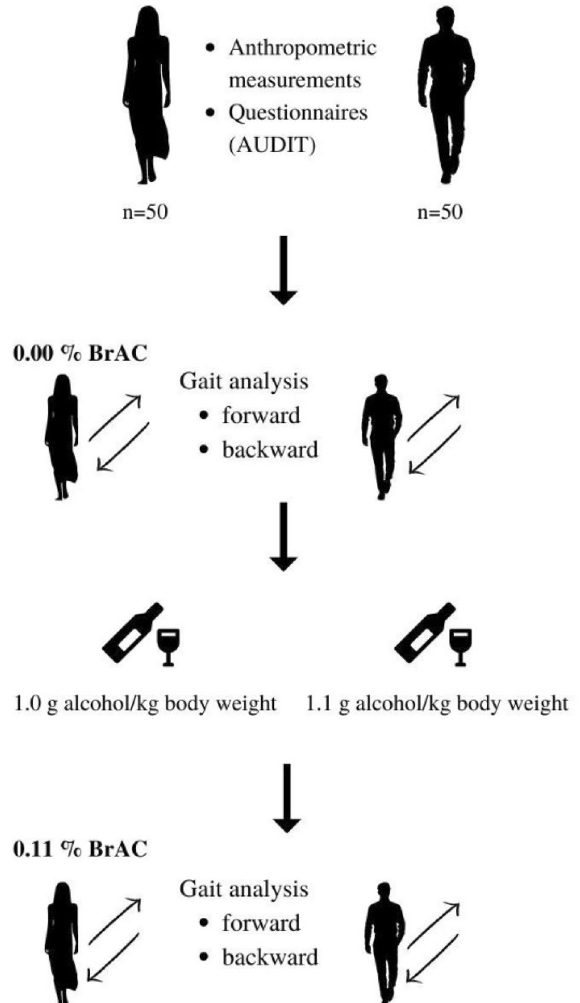
Figure 1. The data collection design. Canva. https:// www. canva.